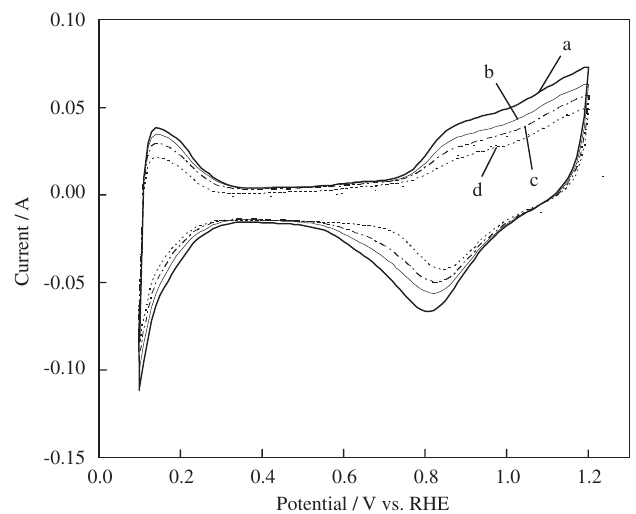
Figure 4. Change in the electrochemically active surface by a cell-reversal experiment: (a) before experiment; (b) after 5 min of experiment; (c) after 10 min of experiment; and (d) after 120 min of experiment. Reproduced with permission from [5]. Copyright Elsevier,